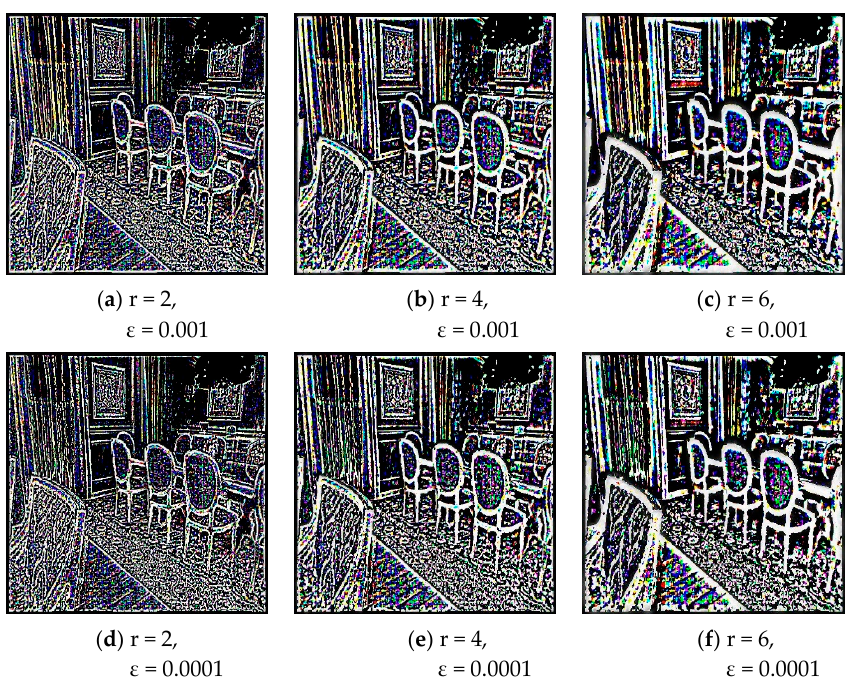
Figure 5. Frequency components after different filtering parameters.